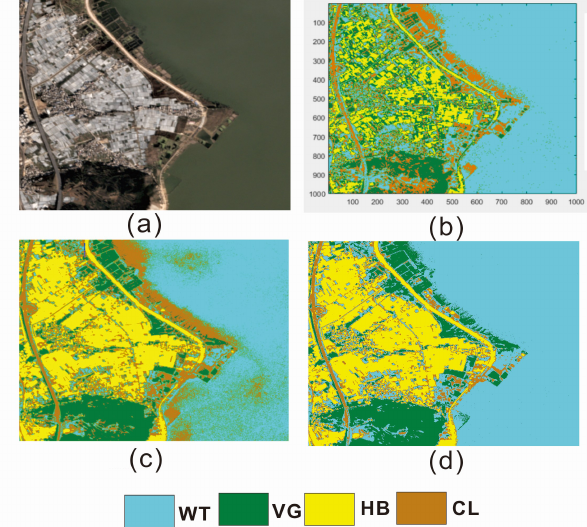
Figure 3. The results of classi fi cation in the third test area by: (a)the original image; (b) the proposed method; (c) Isodata; (d) K-Means . Table 1. Confusion matrix of the proposed